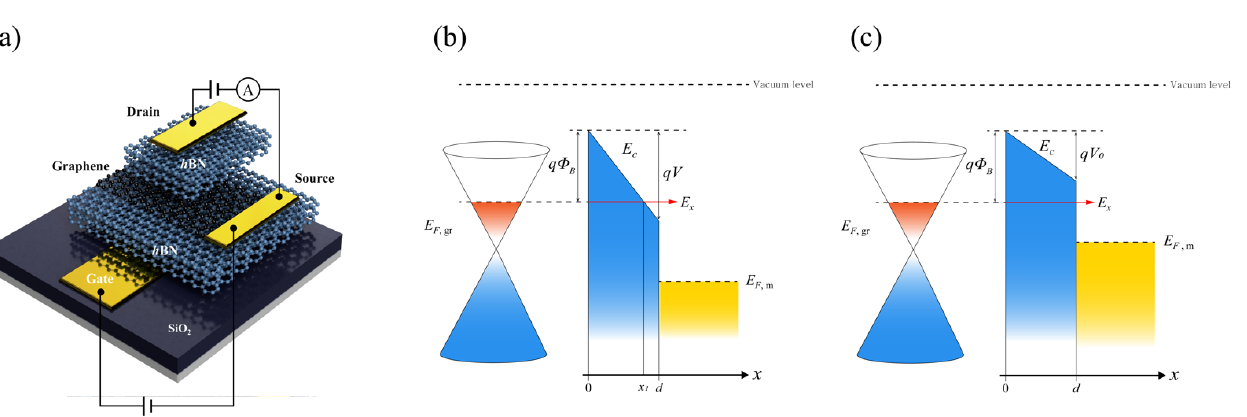
Figure 1. ( a ) A schematic of the field-emission barristor and schematic illustration of the gra- phene/insulator/metal (GIM) junction in Fowler – Nordheim tunneling; ( b ) an illustration of the